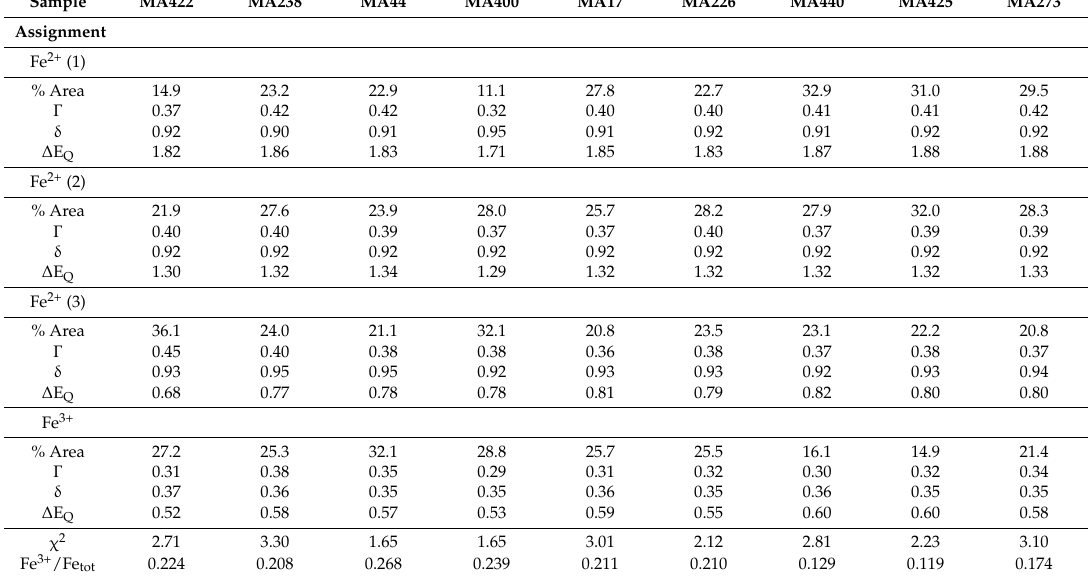
Table 3. Mössbauer parameters obtained for spinel samples at room